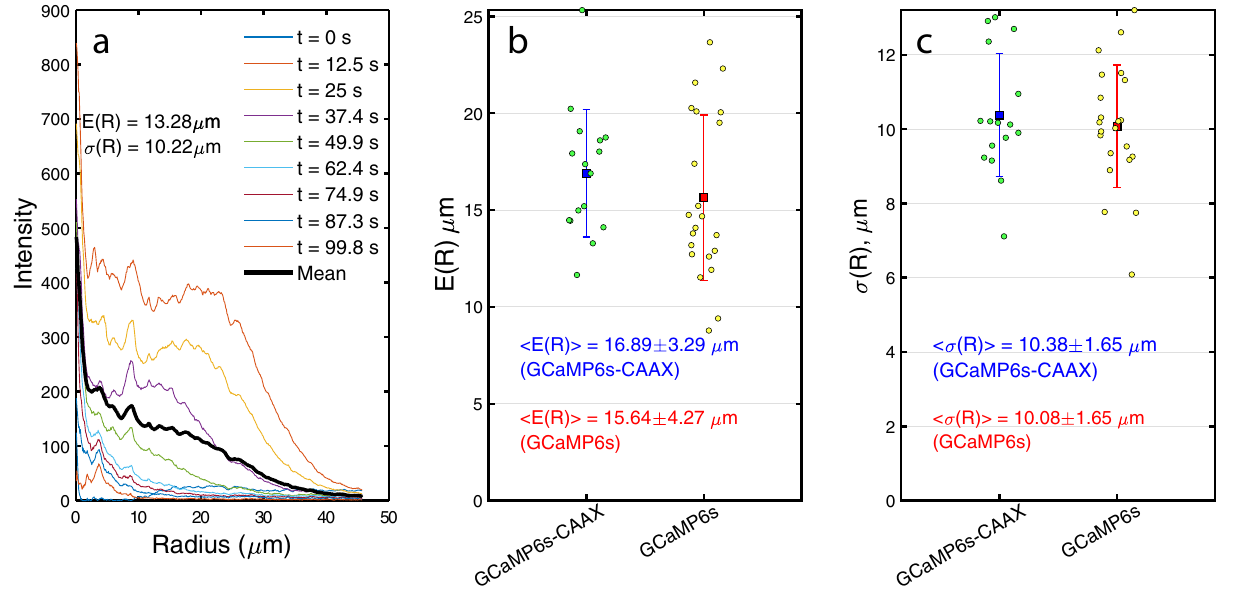
Figure 4. Analysis of the radial distribution of fluorescence intensities from the point of UV-laser damage. Example of a sequence of radial intensity distributions for the probe GCaMP6s-CAAX ( a ). The mean intensity distribution (solid black) is the time average of the radial intensities. The expectation value of the radius, using the mean intensity distribution, is E(R) and is a measure of the characteristic penetration depth of calcium into the cell after damage. The corresponding standard deviation of the mean radial distribution is σ (R). The scatter and mean value of E(R) for a number of cells labeled with the probes GCaMP6s-CAAX (N = 16) and GCaMP6s (N = 22), respectively ( b ). The corresponding scatter and mean value of the standard deviation σ (R) for the same cells (C). Uncertainties in ( b , c ) are ± one standard